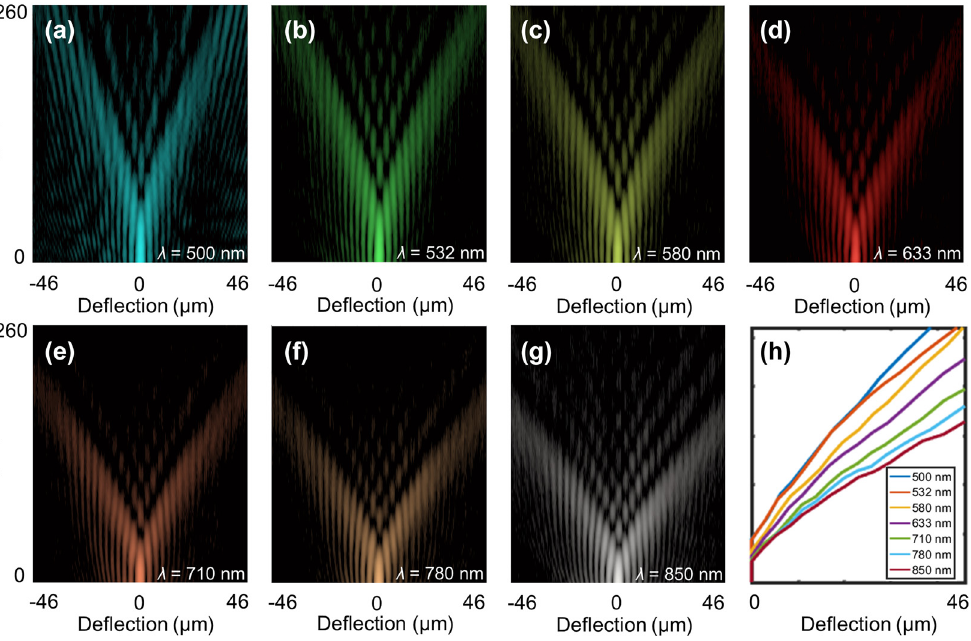
Figure 5: Measured longitudinal intensity distributions of the PB. (a) – (g) Measured longitudinal intensity distributions for the PB with m = 4 at wavelengths of λ = 500, 532, 580, 633, 710, 780, and 850 nm, respectively. To facilitate visualization, the intensity distribution in (a) – (g) are false-colored images in the log scale. (h) Measured beam de fl ection of the main accelerating channel along the longitudinal direction for the above